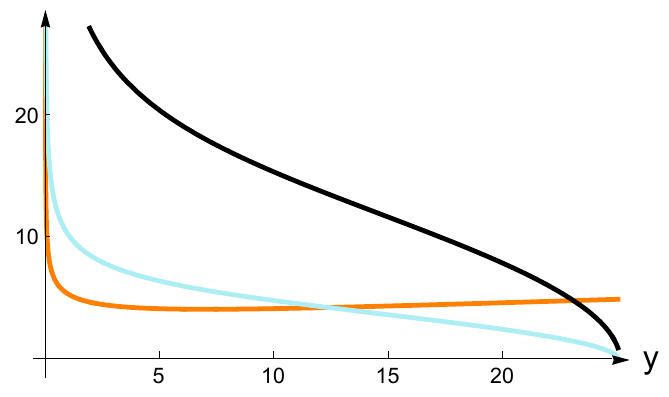
Figure 2 . A numerical solution with M 6 = Tw(M 4 ) , interpolating between an O8-plane on the left, and a regular point on the right. The functions are e A (orange), e B (aqua), e C (black). The parameters in (6.44) are a = 5 , c = 5 , b = 1 , m = 1 0 0